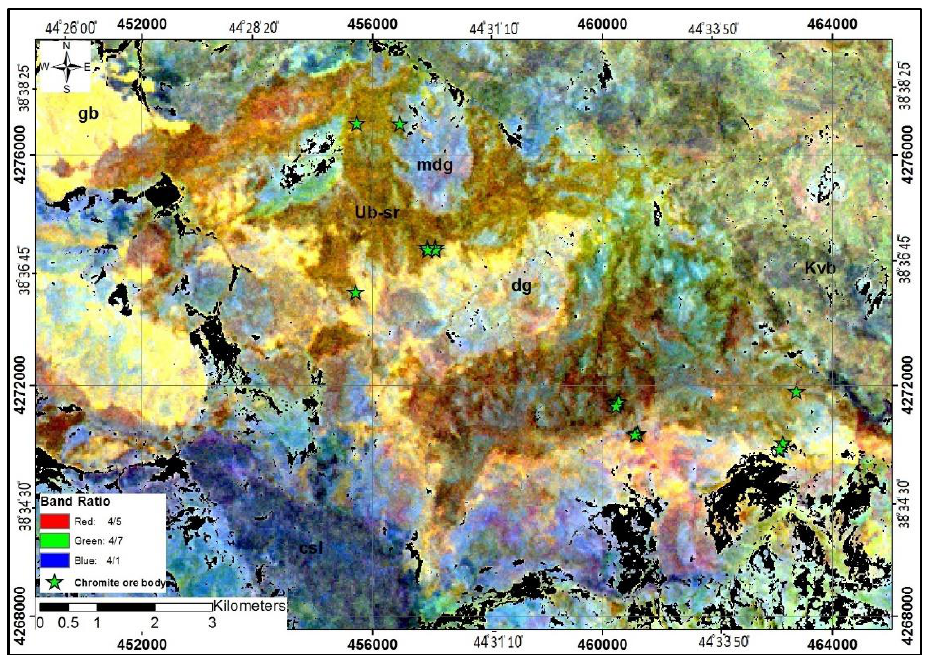
Figure 9. ASTER RGB images of band ratios (4/5, 4/7/4/1) show gabbro-diorite in yellow, serpentin- ized ultrabasic in purple.